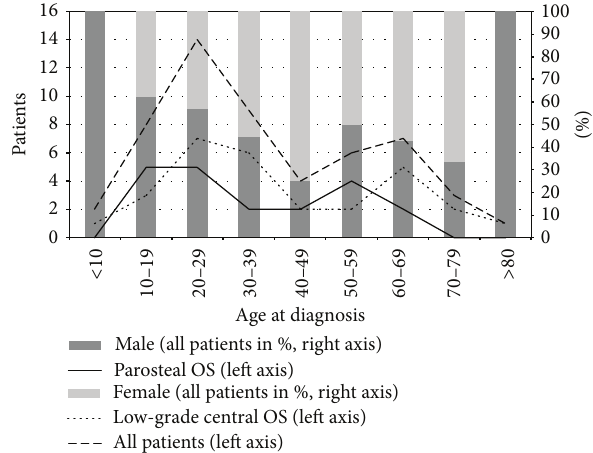
Figure 1: Gender (bar chart, right axis) and age at diagnosis (line diagram, left axis) of 54 patients with low-grade or dedifferentiated osteosarcoma (OS), including separate line diagrams for parosteal and low-grade central